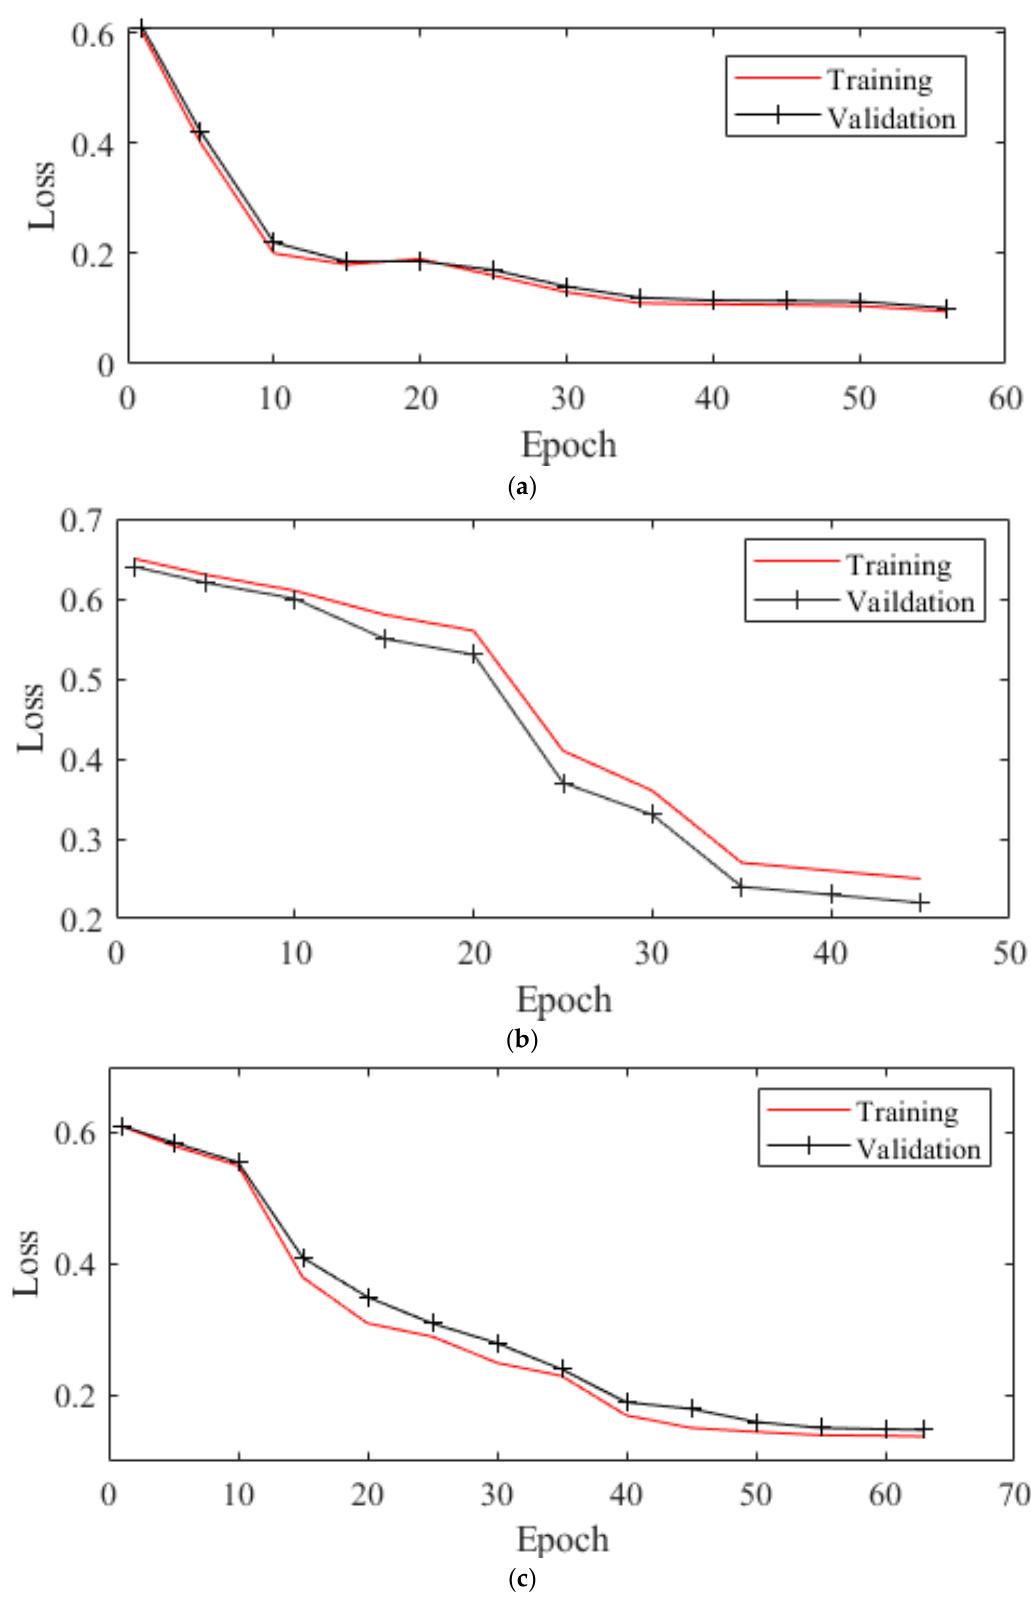
Figure 10. The loss vs. number of epochs on training and validation datasets: ( a ) w 1 ; ( b ) w 2 ; ( c ) w 3 .